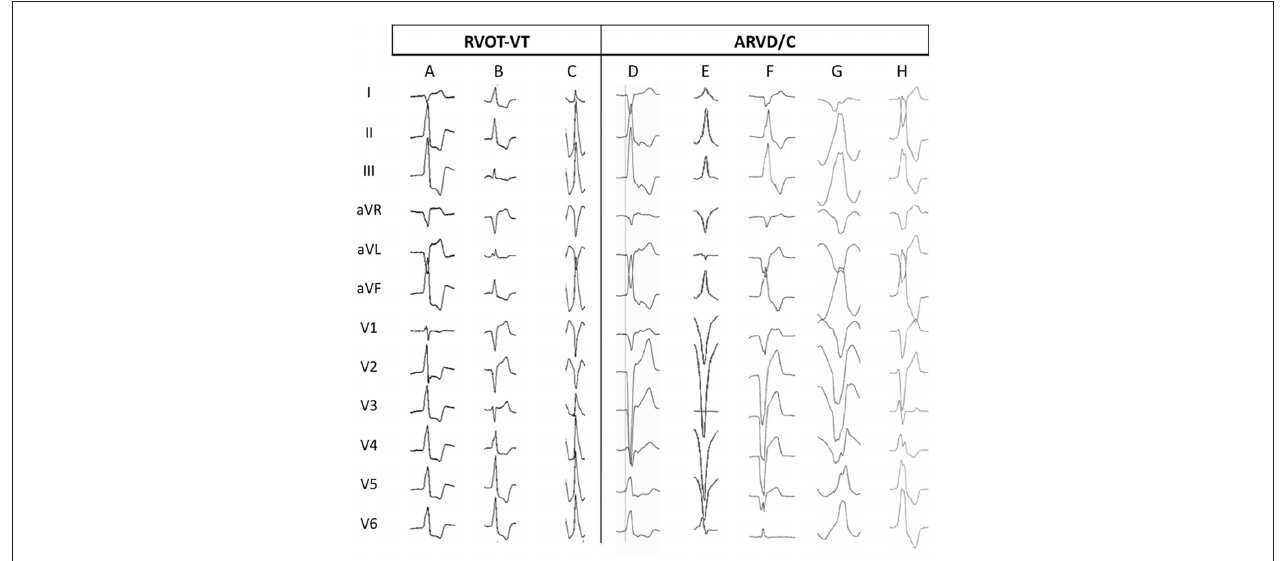
shows late precordial transition V5, wide QRS duration in lead I (124 ms), and earliest onset QRS in V1 (vertical line). (e) ARVD/C VT shows very late precordial transition V6 and wide QRS duration in lead I (126 ms). (F) ARVD/C VT shows very late precordial transition V6 and wide QRS duration in lead I (150 ms). (g) ARVD/C VT shows late precordial transition V5, wide QRS duration in lead I (160 ms), and notching of the QRS (II, III, aVF, V4–6). (H) ARVD/C VT shows wide QRS duration in lead I (128 ms) and notching of the QRS (II, III,